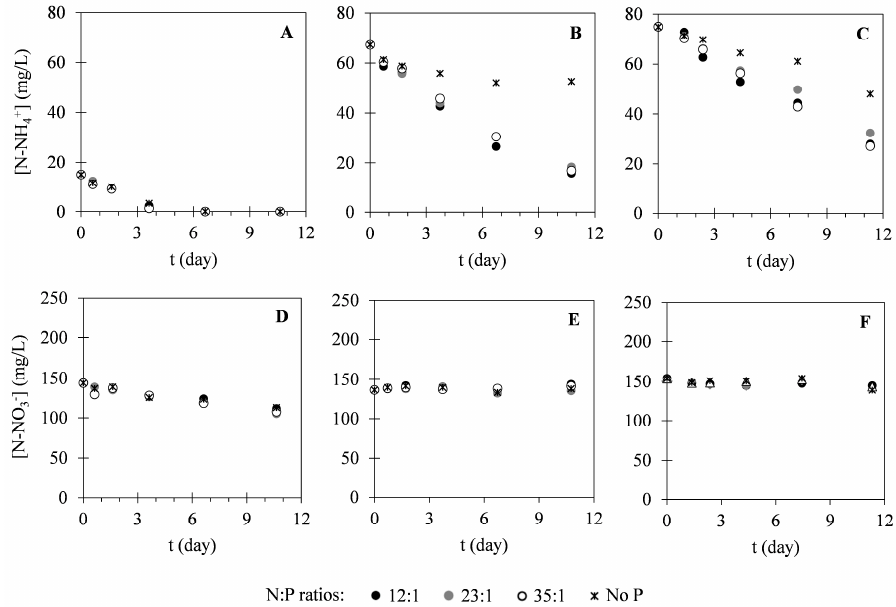
Figure 2. Temporal variation of N–NH 4+ ( A – C ) and N–NO 3 − ( D – F ) concentrations determined in assays I ( A and D ), II ( B and E ) and III ( C and F ) under different N:P ratios. The presented data correspond to the mean obtained from two independent experiments.